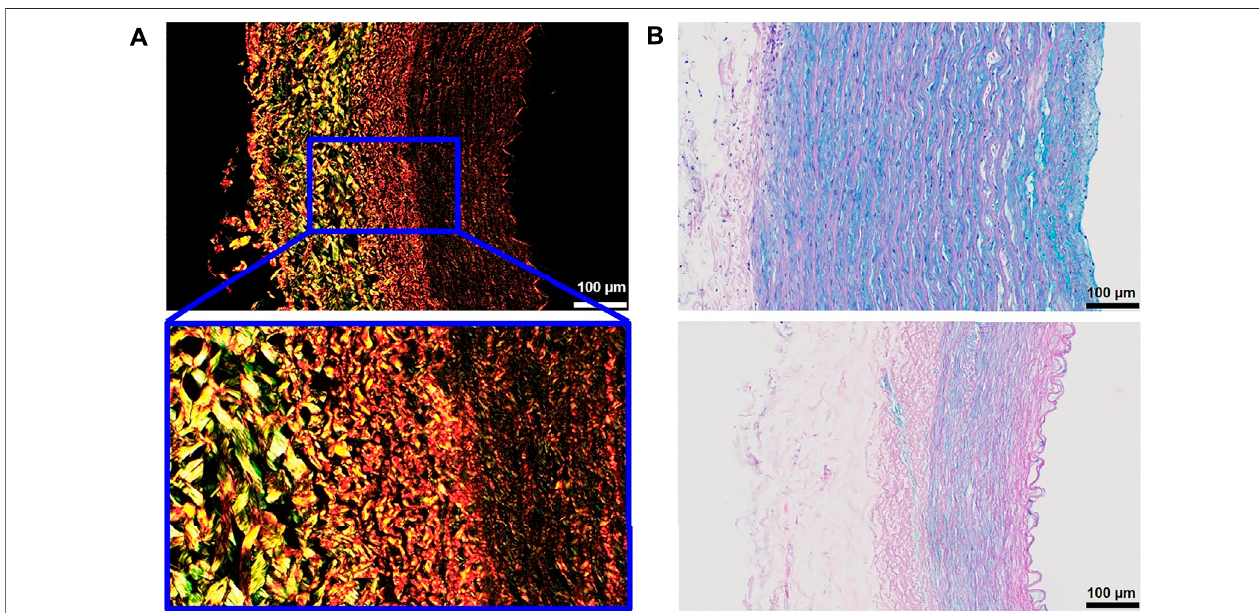
FIGURE4| Collagenandglycosaminoglycans(GAGs)indecellularizedarteries. (A) Collagen fi bersvisualizedbyPicrosiriusredstaininginpolarizedlight. (B) Alcian bluestaininginnative(top)anddecellularized(bottom)tissueshowsthepresenceofGAGs;thelossofbluestainingindecellularizedtissuecanbecausedbytheremoval of GAGs present within